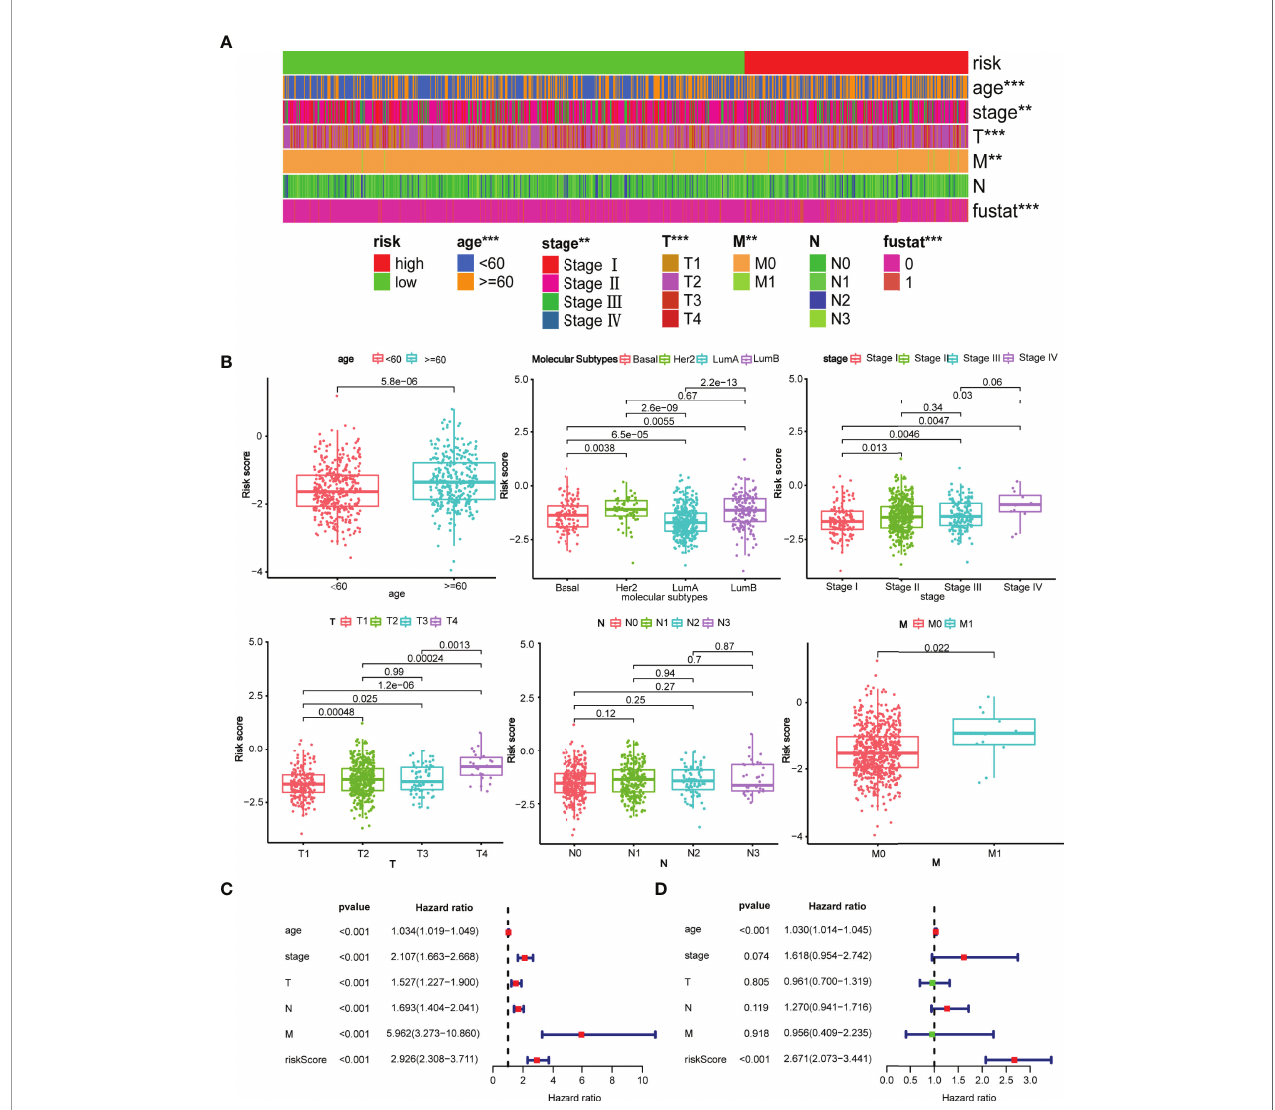
FIGURE 4 | Clinical evaluation of the risk model with pathological parameters. (A) The distribution of the model with the clinicopathological features including age, stage, TNM stage, survival state; **p < 0.01 and ***p < 0.001. (B) Comparison of risk score between patients with different pathological parameters. Age, molecular subtype, clinical stage, T stage, M stage were signi fi cantly associated with the risk score, while N stage was not; (C) Forrest plot of univariate Cox regression analysis. The result revealed that age, clinical stage, T stage, N stage, M stage, and risk score were statistically different. (D) Forrest plot of multivariate Cox regression analysis. Either age or risk score acted as an independent prognostic